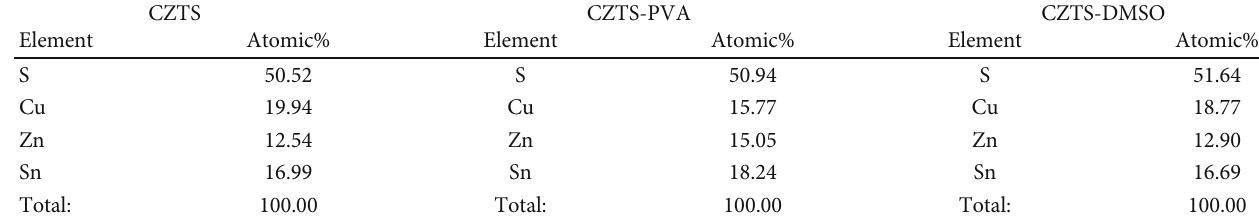
Table 1: EDS analysis obtained alloying element average concentration for the CZTS, CZTS-PVA, and CZTS-DMSO doctor-coated thin fi lms.